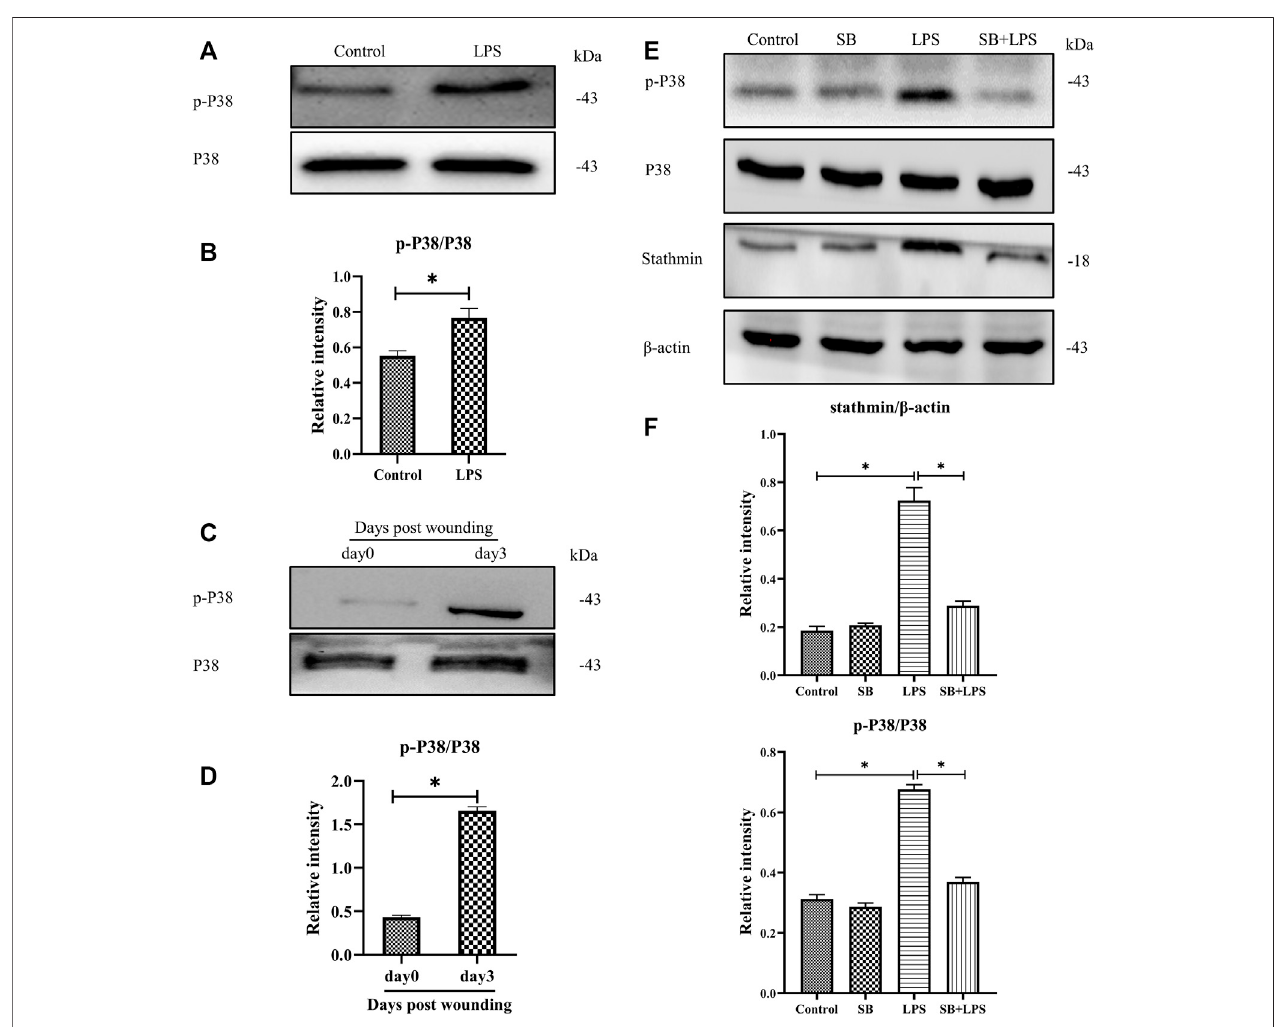
FIGURE 4 | P38/MAPK activation mediates stathmin expression in LPS-induced HDF migration and proliferation. (A) Western blotting was performed to detect p38/MAPK activationwithor without LPS, and (B) the results werequantitatively analyzed ( n (cid:1) 5). (C) Westernblotting wasperformed to detect p38/MAPK activation in wound edge tissue post wounding, and (D) the results were quantitatively analyzed ( n (cid:1) 5). (E) Western blotting was performed to detect stathmin expression and p38/ MAPKactivationafterLPStreatmentwithorwithoutthep38/MAPKinhibitorSB,and (F) theresultswerequantitativelyanalyzed( n (cid:1) 5).SB,SB203580.Thesedata are represented as the mean ± SEM. * p < 0.05 was considered to be signi fi cant.